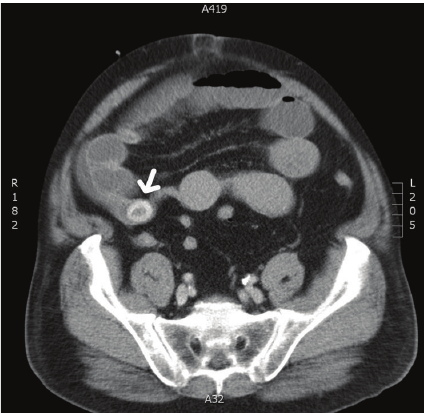
Figure 1: CT scan of the abdomen revealing 25 mm hyperdense lesion within the distal small bowel (white arrow).